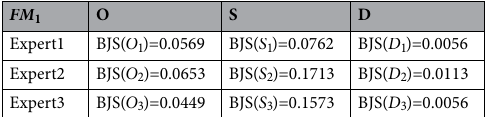
Table 5. The average divergence of risk factors in FM 1 .